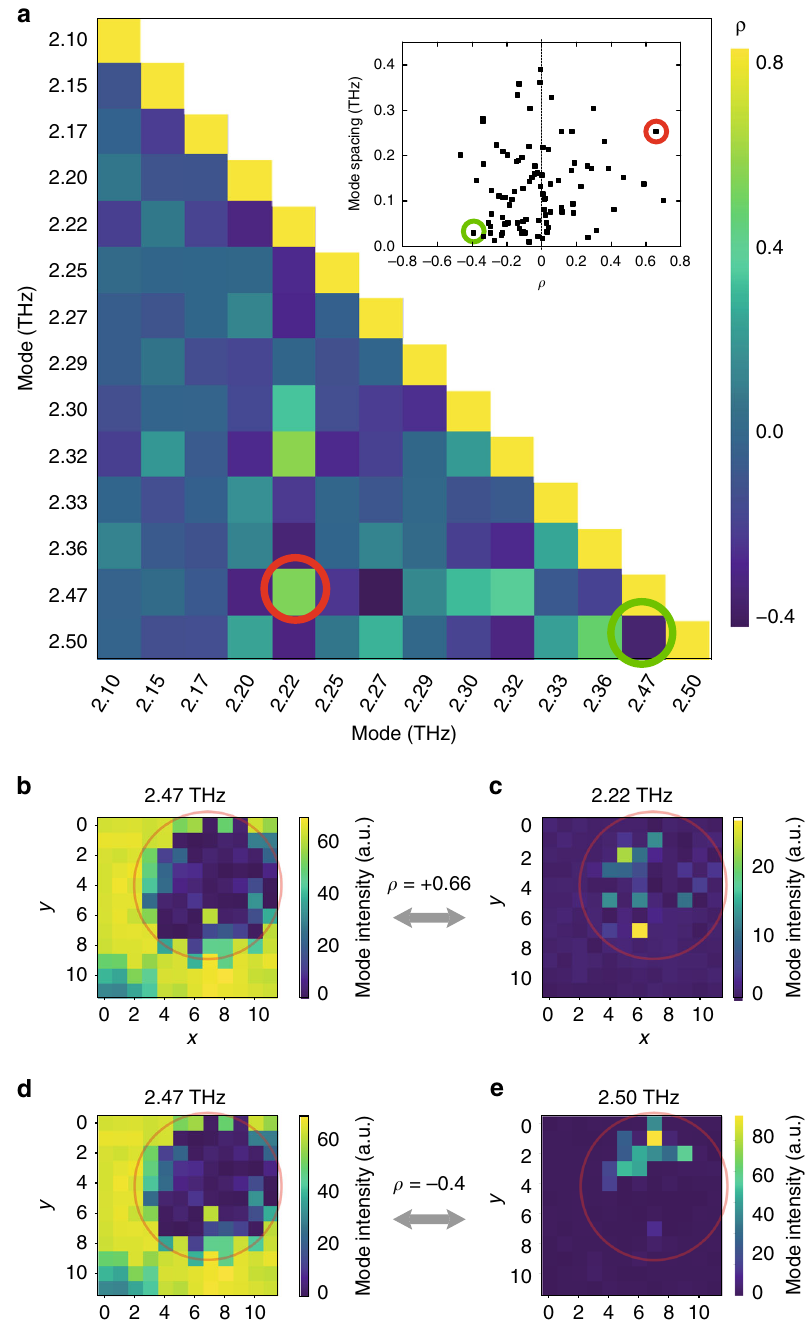
Fig. 4 Correlation between mode mappings. a Pearson cross-correlation, ρ , between the mappings of 14 different modes. The red circle indicates a positive correlation of ρ = 66% for the modes at 2.47 and 2.22 THz, while the green circle pinpoints a negative correlation of ρ = − 40% for the modes at 2.47 THz and 2.50 THz. For each pair of modes, the scattered plot in inset reports the cross-correlation between modes as a function of their frequency spacing. We observe a concentration of negative correlations for pairs close in frequency. The green and red circles correspond to the ones displayed in the main panel. b , c Mappings of the two modes at 2.47 and 2.22THz, respectively, whose correlation is red-circled in a . d , e Mapping of the two modes at 2.47 THz and 2.50 THz, respectively, whose correlation is green-circled in a elements corresponds to the intensity obtained for the NIR beam position, but at different locations of the spot its intensity is being located at a given location ( x , y ) among the 12 × 12 spot strongly modulated while other modes are strongly impacted as positions on the chip ( “ Methods ” ). Figure 3b, c displays the well (Supplementary Fig. 10). In sharp contrast, the mode evolution while scanning the perturbation of a mode at 2.29 THz addressed in Fig. 3c does not emit in the spectrum collected (label “ 2 ” in Fig. 1c) and at 2.25 THz (label “ 1 ” in Fig. 1c), without perturbation. At very speci fi c spot positions (e.g., yellow respectively. The mode addressed in Fig. 3b emits for any spot spot at ( x , y ) = (5, 1) or green spot at (8, 5)) the mode starts lasing